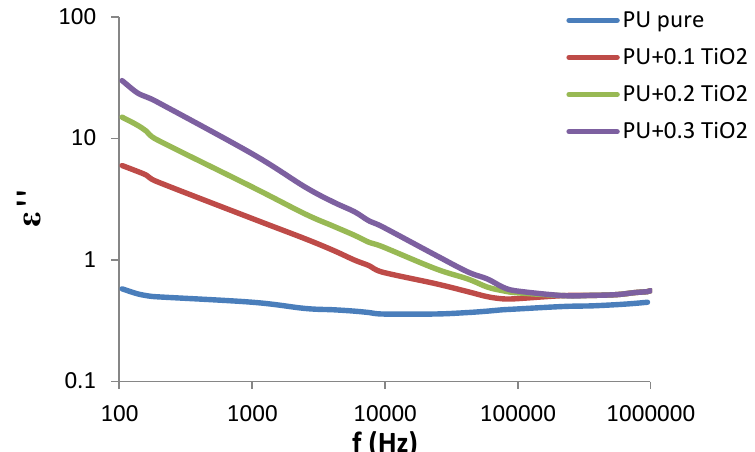
Fig. 3: Dielectric loss vs. frequency for PU-TiO